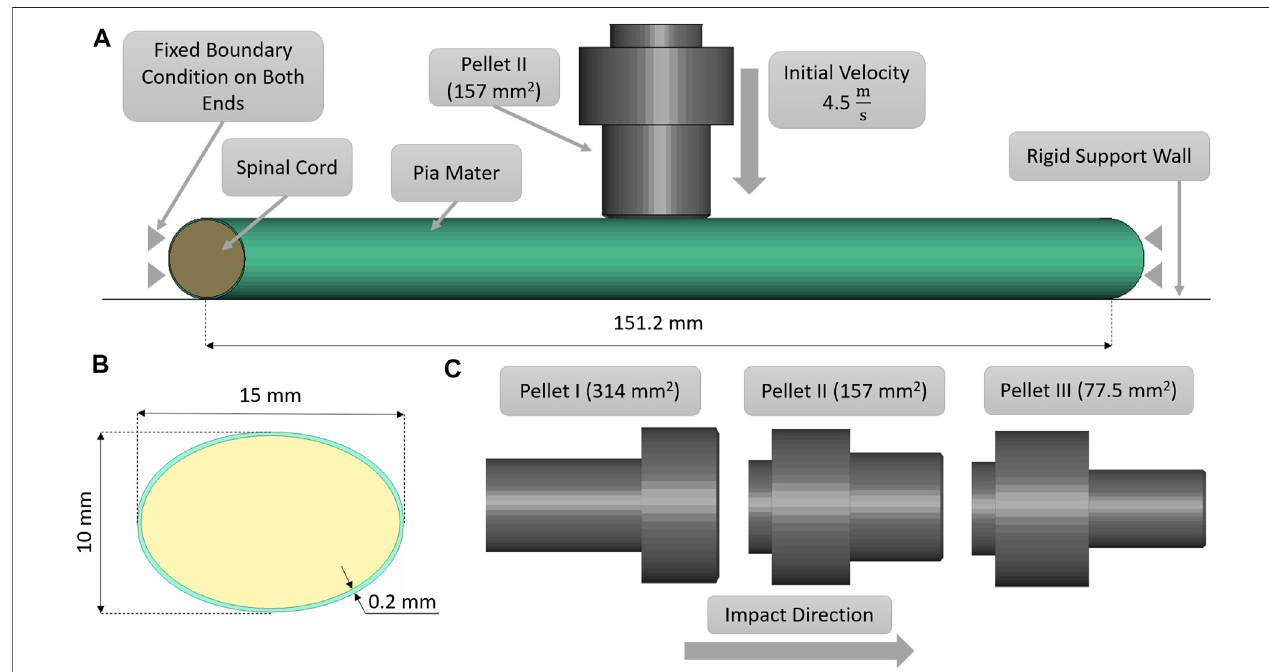
FIGURE2|(A) ImpacttestsimulationsetupwiththePelletIIcase. (B) Sagittalviewofthespinalcord-piamatercomplexdimensionsusedintheimpactsimulations. (C) Numerical representations of the three pellet